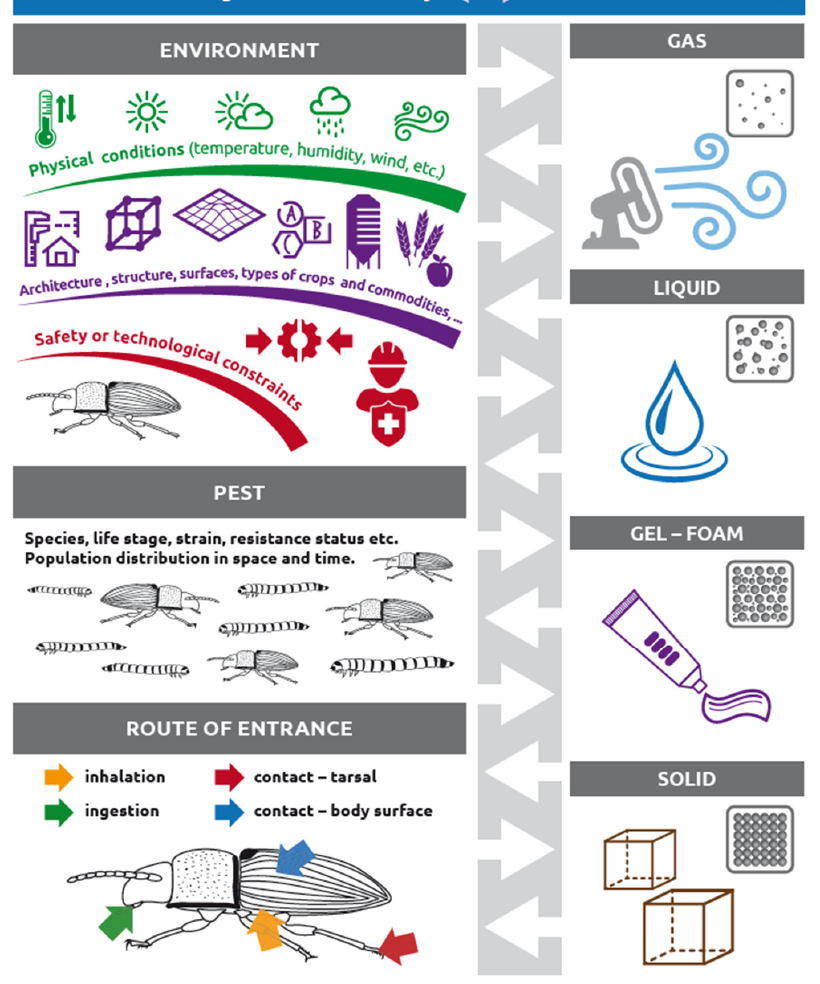
Figure 1. The selection and efficacy of a particular insecticide formulation is affected by a complex interplay between multiple factors that include insecticides, environment (temperature, humidity, crop, structure of stores, technology), workplace and environmental safety and technological constraints, and pests (species, stage, resistance, targeted route of entry into the insect body, etc.). Formulations of insecticides are traditionally [16,17] divided according to the specific routes of entry [18,19] and their physiological effects, such as stomach poisons, contact poisons, and fumigants. The main routes of insecticide entry to the arthropod body are visualized in Figure 1 and include the oral-digestive route (digestive tract), the dermal- contact route (tarsi, antennae, or the entire surface of the cuticle and intersegmental mem- branes), and the respiratory-inhalation route (spiracle and insect tracheal system, mite in- tegument). The main routes of entry and their physiological effects are traditionally asso- ciated with certain physicochemical formulations of insecticides, such as gaseous (fumi- gants and vapors), liquid (sprays/aerosols), solid (dusts), and gel or foam (baits) insecti- cide forms [20,21]. Currently, there exists a conspicuously high degree of diversity of in- secticide physical formulations and variance in their usage at both global and local scales. Presumably, this phenomenon can be explained by the technological adaptation of pesti- cide formulations to various pest body entry routes and the complex environmental and